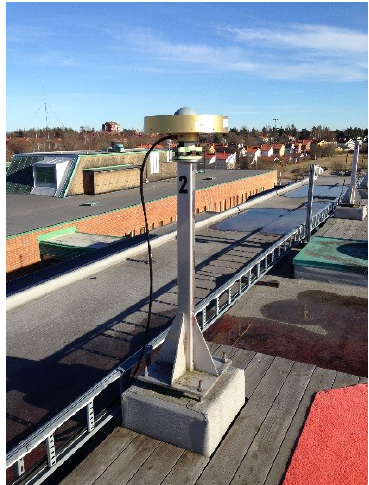
Figure 3: Photo of the antenna site in